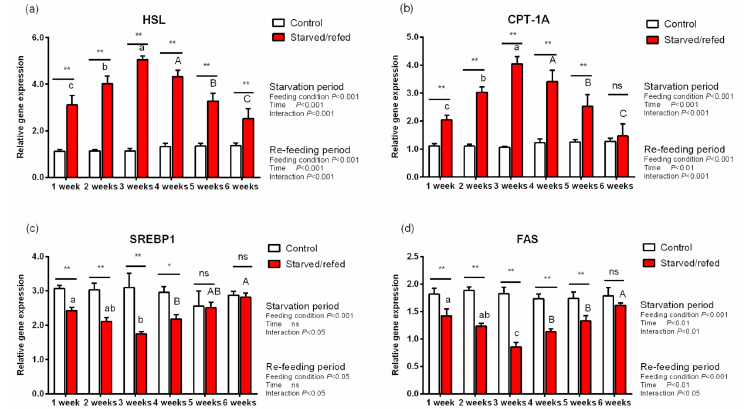
Figure 1. The expression of lipid metabolism genes in the hepatopancreas of O. macrolepis exposed to starvation and refeeding periods. Different superscript letters in the same column indicate a significant difference between successive times ( p < 0.05). Significant differences between the two groups at each sampling time are identified with different markers (* p < 0.05; ** p < 0.01; ns, no significant difference). HSL ( a ), hormone-sensitive lipase; CPT-1A ( b ), carnitine palmitoyl transferase